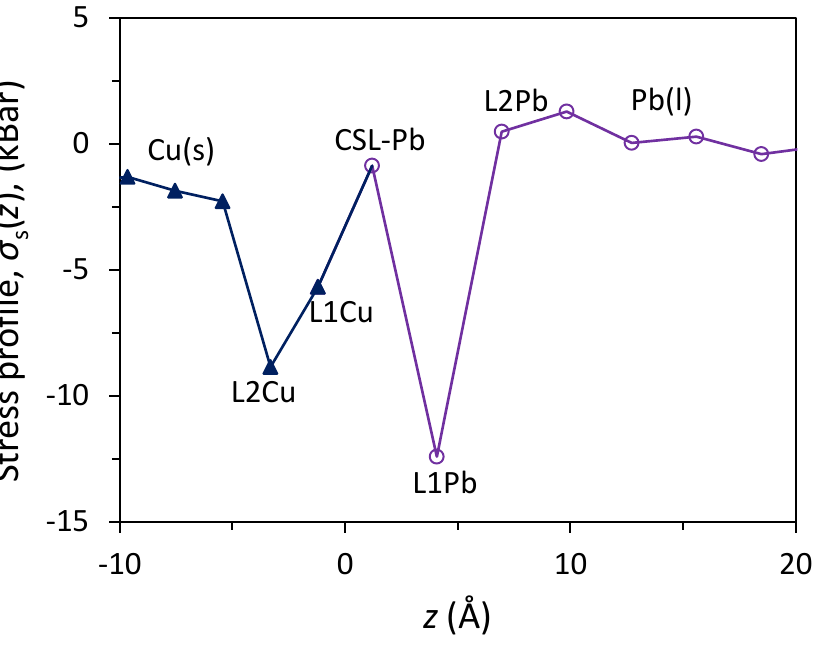
Figure 9. Stress state at the Pb(l)/Cu(s) interface [27]. Local stress distribution, σ s ( z ), as a function of distance away from the Pb(l)/Cu(s) interface, equilibrated at 625 K. Prenucleation creates a coincidence site lattice (CSL) on the Cu substrate surface, and the CSL-Pb layer has become the new surface layer on top of the original Cu substrate (Figure 10a). The time-averaged atomic positions in the superimposed CSL-Pb/L1Cu layers exhibit a regular hexagonal pattern, which is too fine to be an edge dislocation network as observed in the systems with small negative misfit [18]. The relationship between CSL-Pb and L1Cu can be best described by a CSL: {111}<110>Pb // {111}<110>Cu and 3 d Pb<110> = 4 d Cu<110> matching of atomic spacings along the <110> directions on both {111}Pb and {111}Cu, where d is the atomic spacing along the <011> direction (Figure 10b,c). This is equivalent to the low-energy Σ 7 CSL in the grain boundary